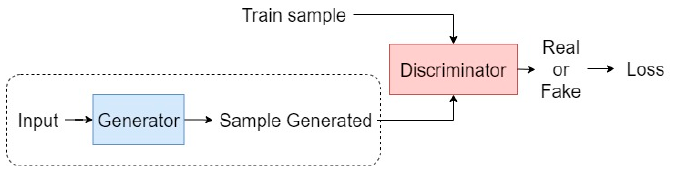
Figure 1. Schematic of the training of a GAN. The dashed line shows the process of sample genera-